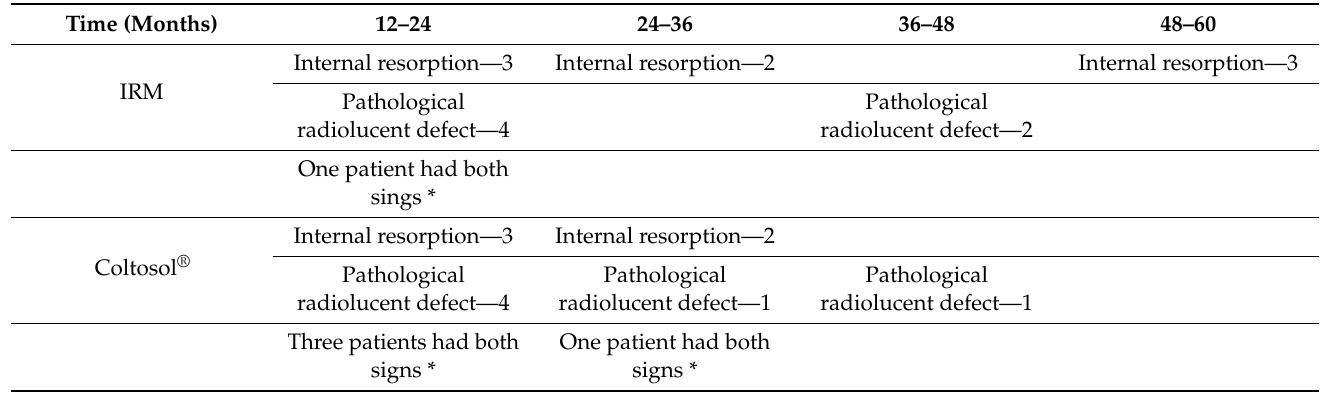
Table 2. Reasons for treatment failure.